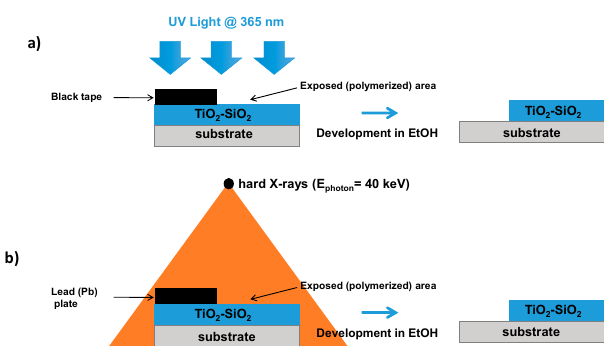
Figure 2. Photosensitivity test for TiO 2 -SiO 2 using: ( a ) The UV lamp (UWAVE) emitting at 365 nm, ( b ) the MoperiX facility delivering hard X-ray photons (40 keV). In both cases, the development is made in ethanol solution.